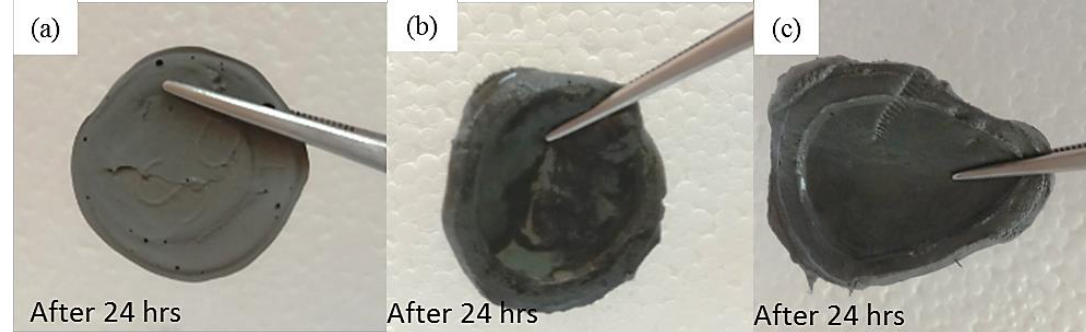
Figure 6. The desiccation observations after 24 h for sample: ( a ) S1-70, ( b ) S2-70, and ( c ) S3-70.